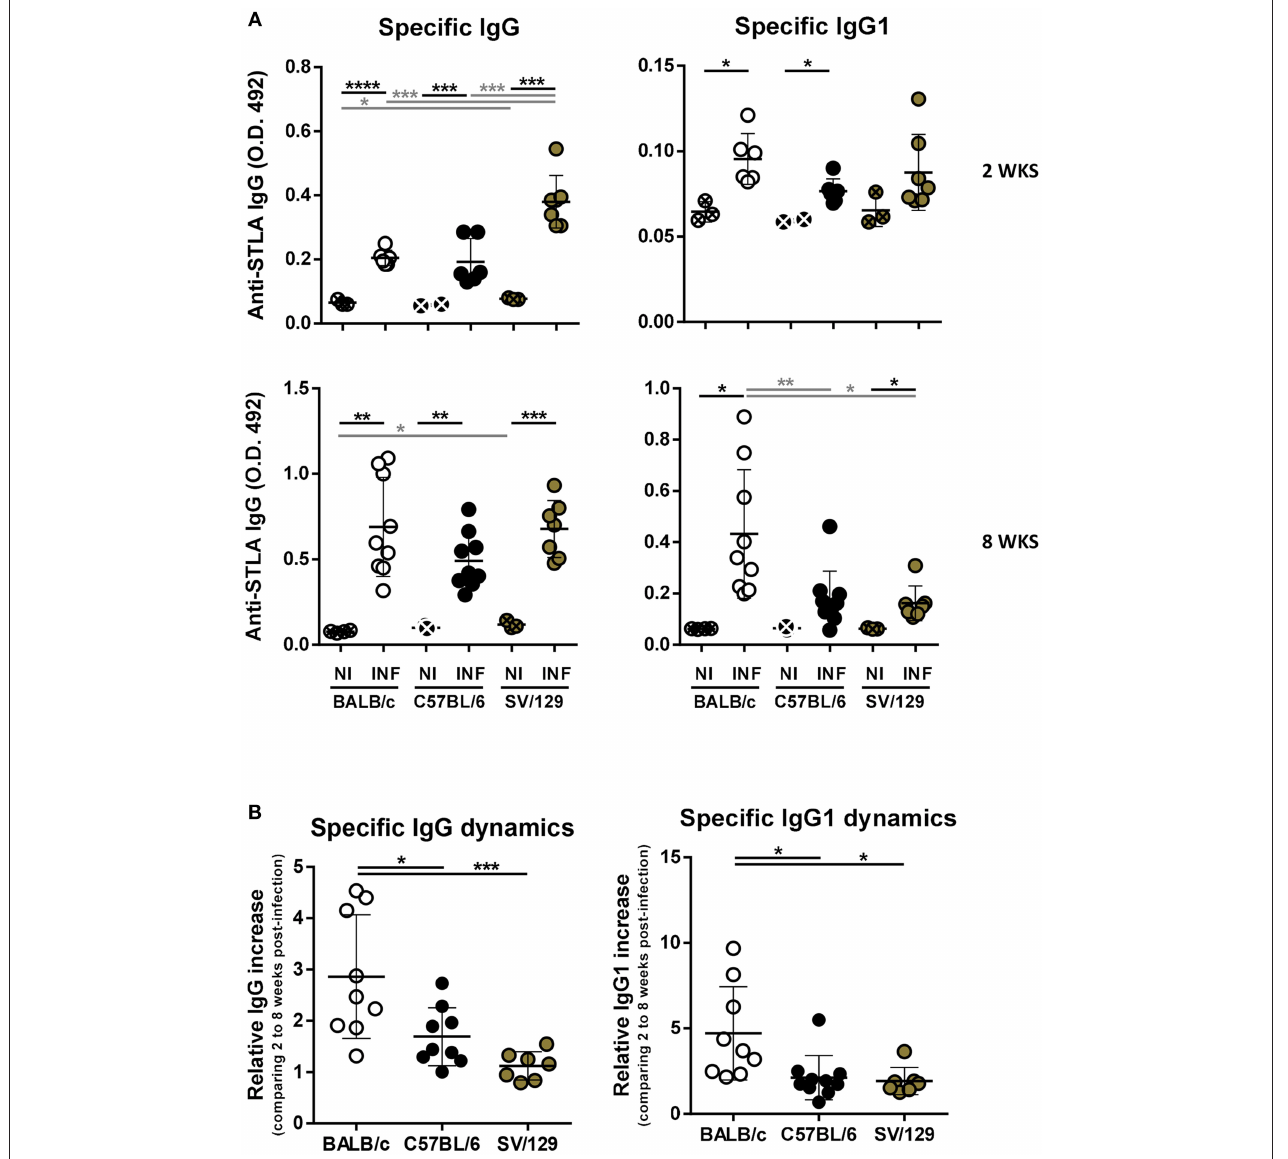
FIGURE 6 | Specific humoral response dynamics in the different L. infantum infection murine models. BALB/c (white circles), C57BL/6 (black circles), and SV/129 (brown circles) mice were infected intraperitoneally with 1 × 10 8 L. infantum promastigotes and euthanized 2 or 8 weeks after. (A) Specific seric IgG and IgG1 levels against parasite’s soluble extract were determined by ELISA for the different infection models and the respective controls in the two time-points evaluated. (B) Specific immunoglobulin dynamics was calculated dividing the values obtained for 8 weeks-infected animals (normalized against the respective controls) by the average of the same values obtained for 2 weeks-infected animals. Results are representative of at least two independent experiments. Each dot represents an animal. Average and SD of the values within each group are shown. Statistical differences are properly identified. One Way ANOVA (with Tukey’s post-hoc analysis) was used for comparisons between the different murine strains (infected or non-infected; gray lines), as well as for comparison of normalized values (black lines); t -tests (black lines) were performed for comparison between infected animals and controls from the same strain: * p ≤ 0.05, ** p ≤ 0.01, *** p ≤ 0.001, and **** p ≤